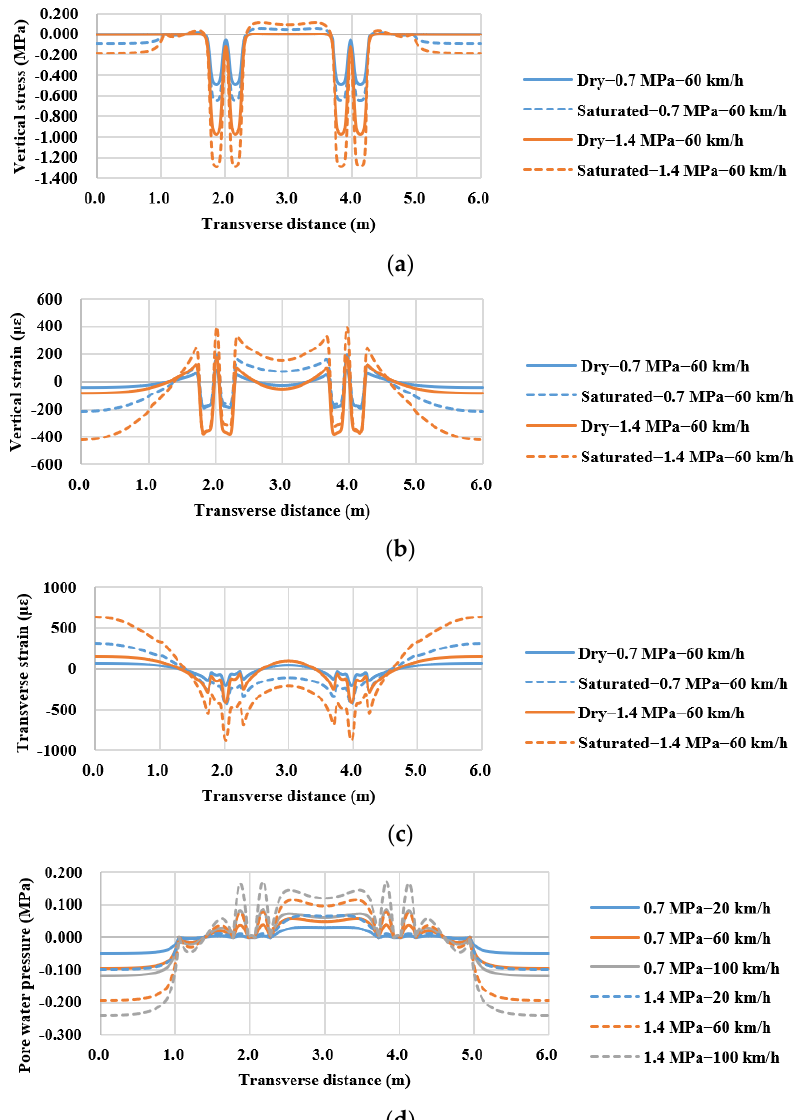
Figure 15. Transverse distributions of dynamic responses at the bottom of the upper layer inside dry and saturated asphalt pavement (h = 0.05 m): ( a ) Vertical stress; ( b ) Vertical strain; ( c ) Transverse strain; ( d ) Pore water pressure.